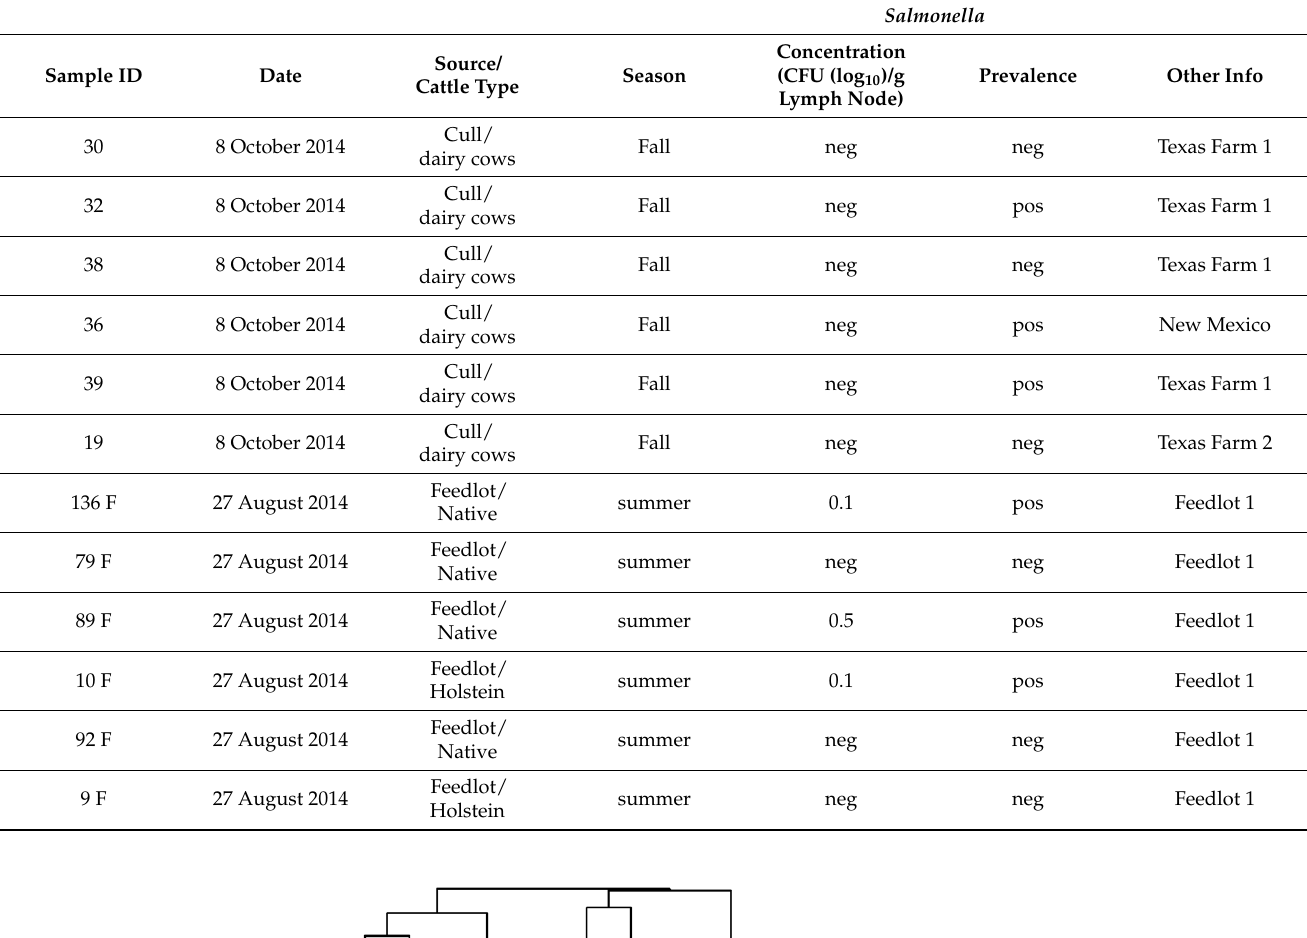
Table 4. Details of cattle cull or dairy, positive or negative for Salmonella in the sub-iliac lymph node, collected for kinome analysis.